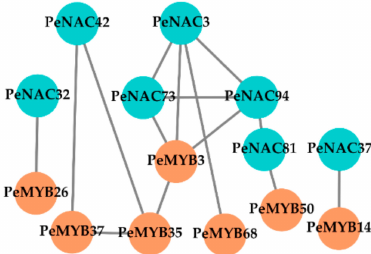
Figure 6. Positive co-expression network of PeNAC s and PeMYB s. The green and orange circles represent PeNAC s and PeMYB s